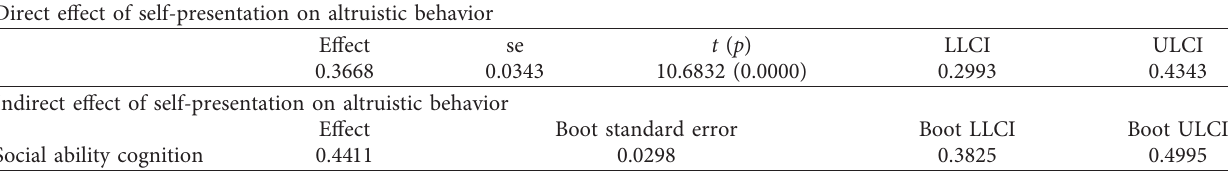
Table 4: Bootstrap significance test of social ability